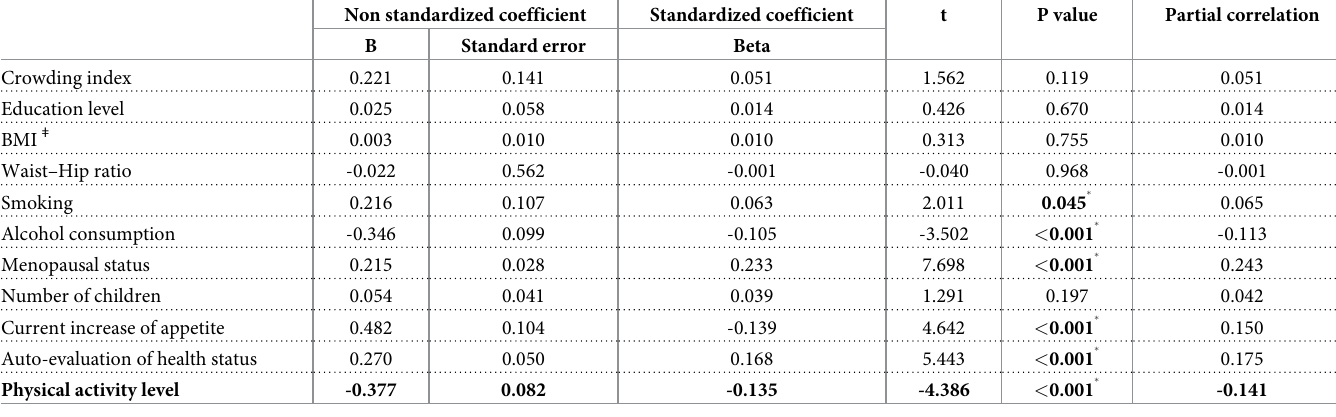
Table 6. Multiple regression models of factors associated with the vasomotor